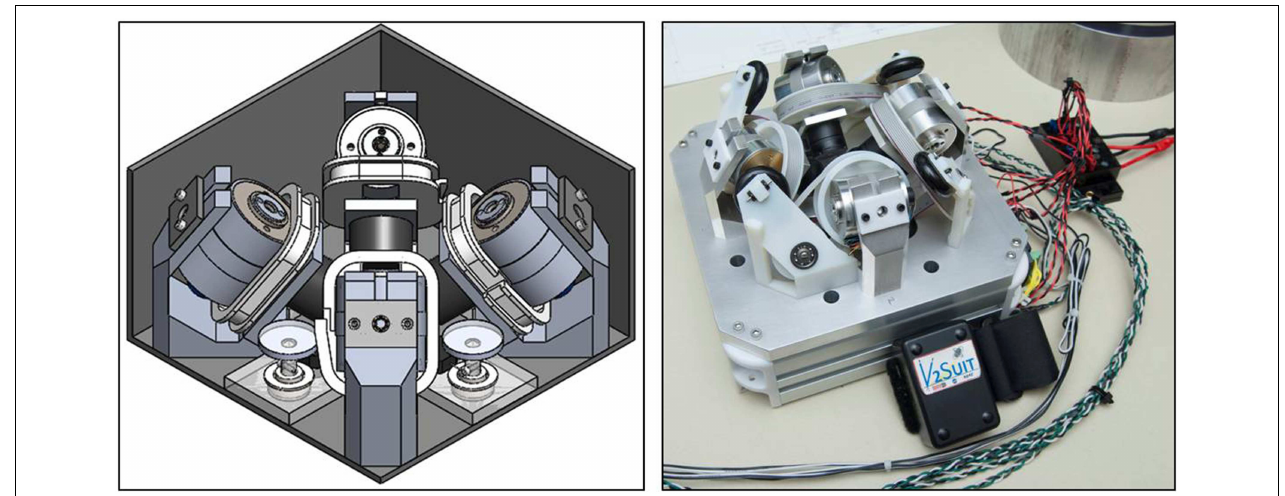
FIGURE 7 | Left: Detailed mechanical design of a prototype V2Suit module. Right: As built V2Suit CMG array